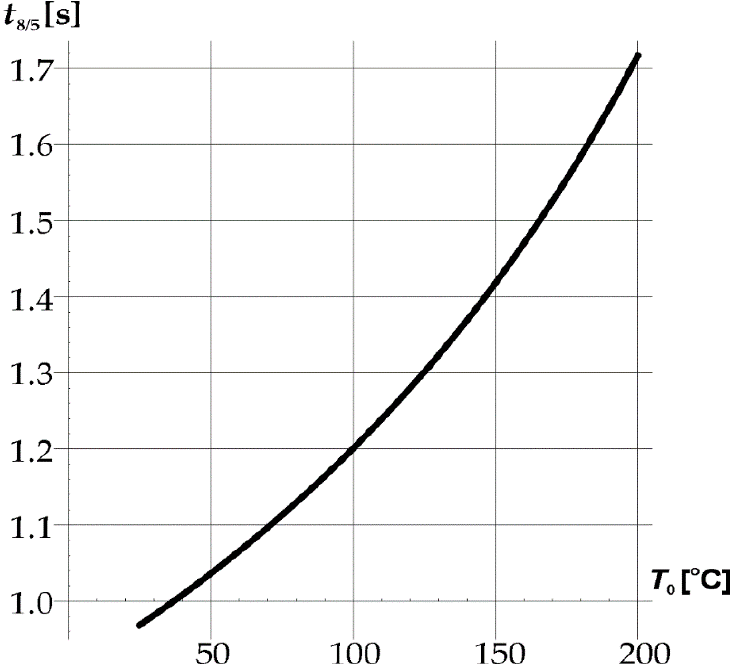
* Number of max/min—minima and maxima of the propagating acoustic wave.